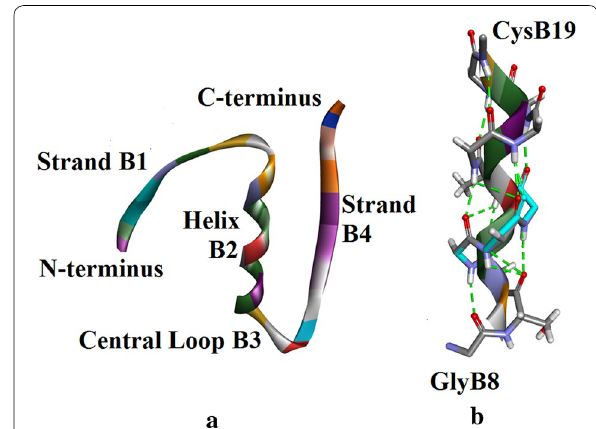
Fig. 6 a Insugen (I) chain B secondary structure motifs. b Chain B Helix B2: GlyB8‑CysB19. H‑bonds are shown as green dashed lines . Main chain atoms only are shown. Light blue regions correspond to residues with double side chain conformations. Drawn with Biovia, Discovery Studio 2016